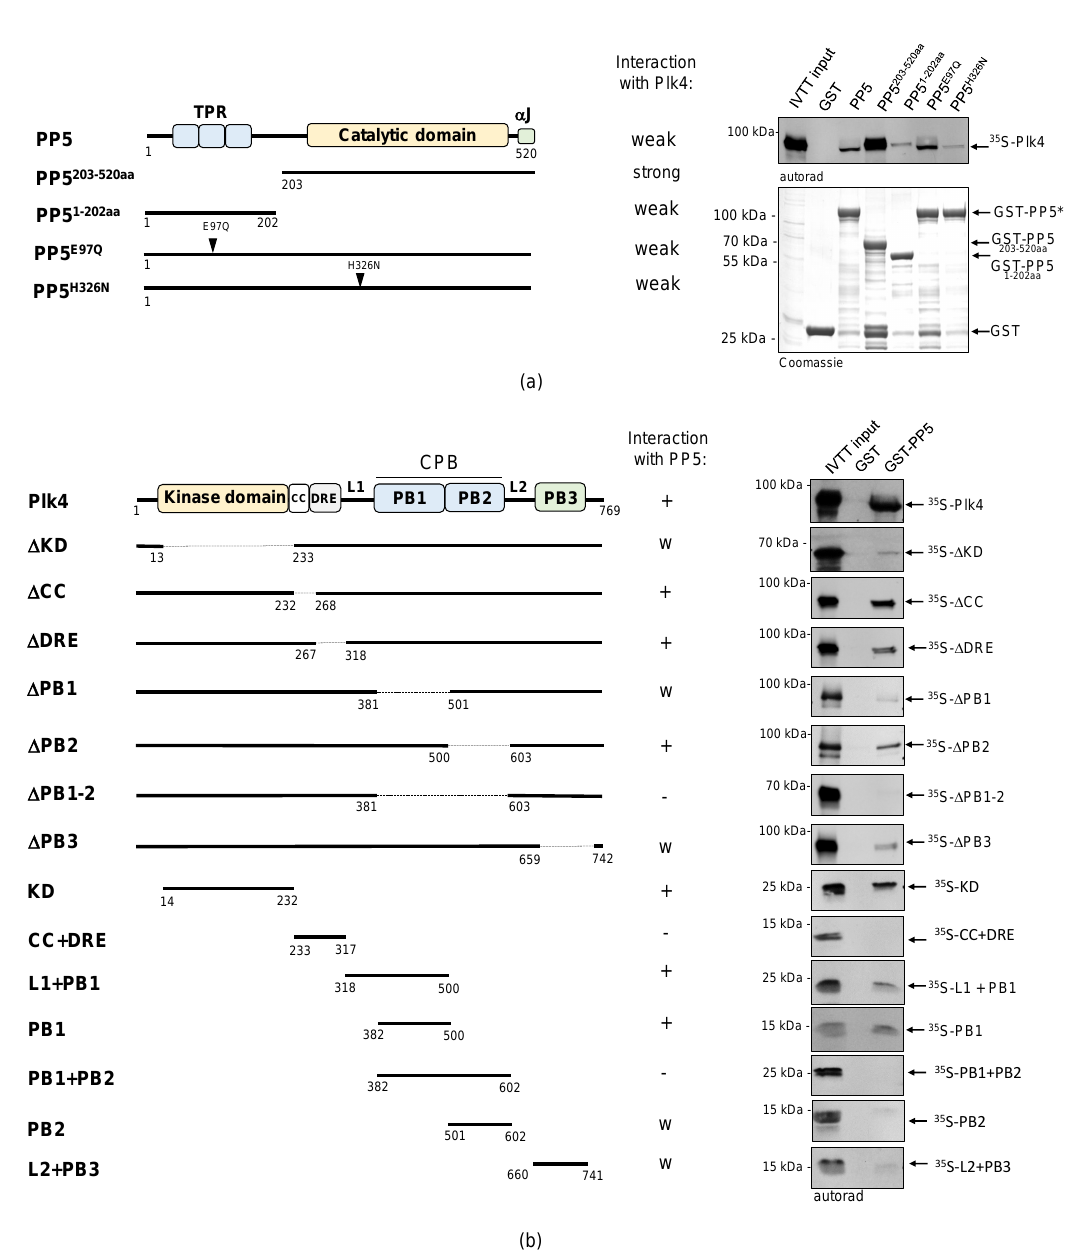
Figure 2. The catalytic domain of PP5 interacts with the kinase domain and PB1 domain of Plk4. ( a ) GST-IVTT in vitro binding assay: autoradiogram (right panel) shows that in the absence of the TPR-domain (catalytic domain only), GST-PP5 203 − 520aa binds more strongly to 35 S − Plk4, in vitro. The wild type and hyperactive GST-PP5/PP5 E97Q bind moderately, while the inactive GST-PP5 H326N and the TPR domain-containing GST-PP5 1 − 202aa bind weakly to 35 S-Plk4. The Coomassie brilliant blue-stained gel shows the loading of the bait proteins. The asterisk indicates the location of the wild type and point-mutant forms of GST-PP5. GST serves as the negative control. ( b ) Domain mapping of Plk4 was carried out with a GST-IVTT in vitro binding assay. Right panels (autoradiograms) show that GST-PP5 specifically binds to the kinase (KD) and PB1 domains of 35 S-Plk4. GST serves as the negative control. “+” means strong binding; “ − ” means no binding; “w” means weak binding; “ ∆ ” refers to the missing domain/motif of the full length protein (indicated by dashed lines in the diagram); numbers show the position of amino acid endpoints of the truncated proteins. Coomassie brilliant blue-stained gels (loading) are shown in Figure S2. Schematics on the left represent the domain/motif architecture and sizes of PP5 and Plk4 constructs used in this